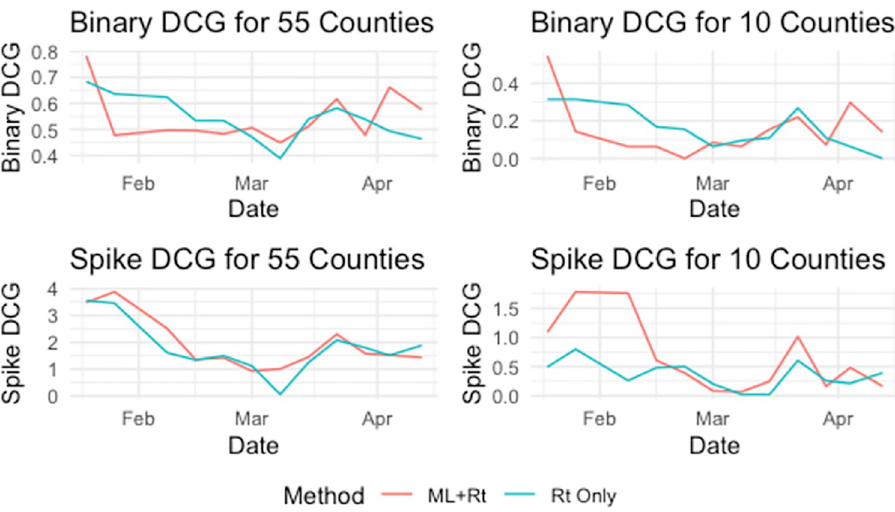
Fig 5. A comparison of the ML+R t and R t Only methods with respect to Binary DCG and Spike DCG over the 17-week evaluation period for both 10 and 55 county recommendations.